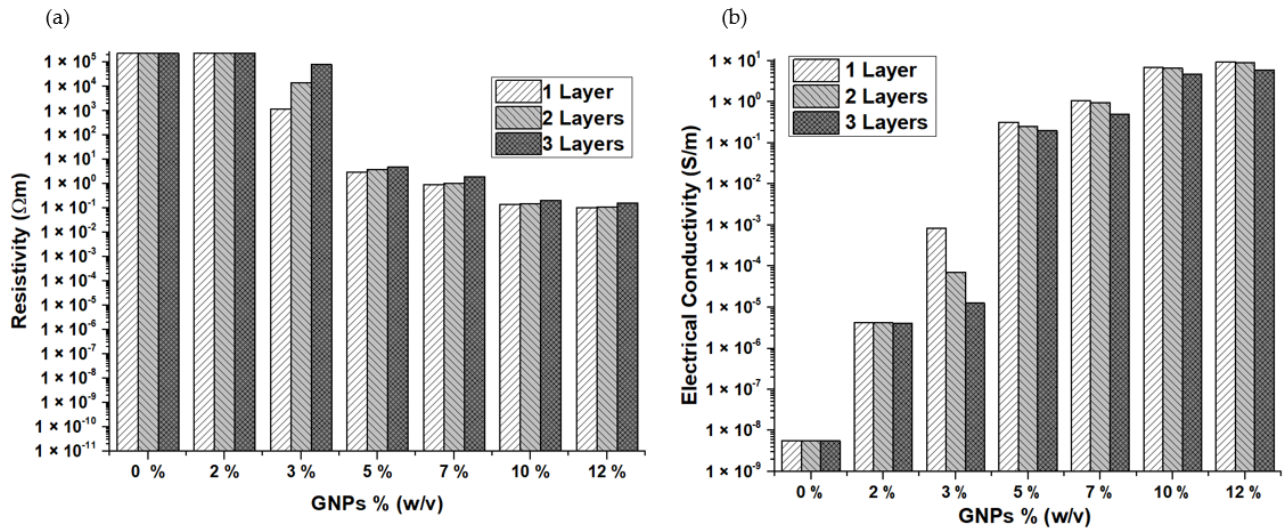
Figure 8. ( a ). Electrical resistivity of cotton fabrics coated with GNPs; ( b ). Electrical conductivity of cotton fabrics coated with